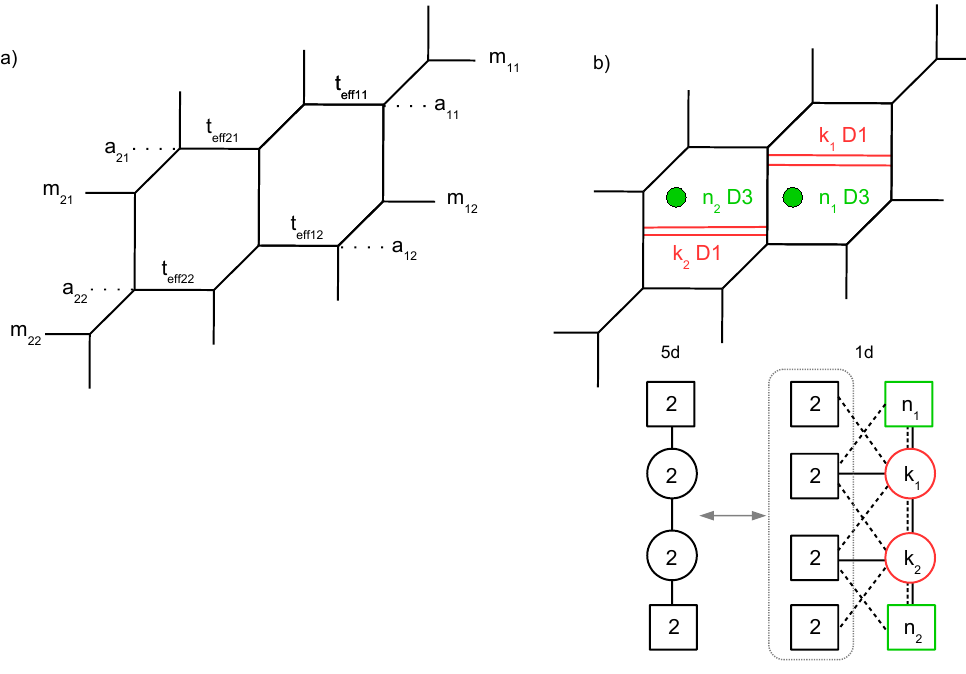
theory. b) Brane setup ADHM quiver N f =2+2